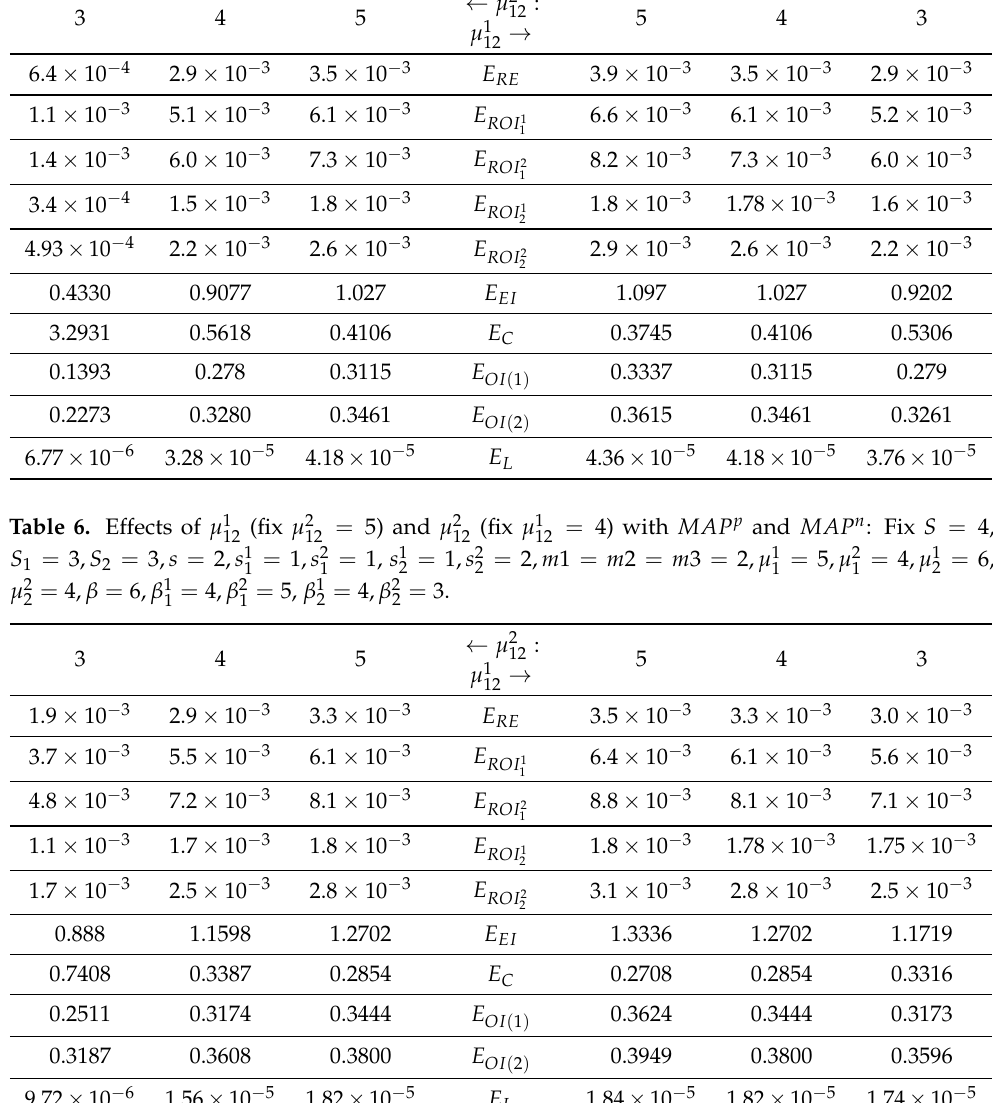
= 5) and µ 2 (fix µ 2 12 12